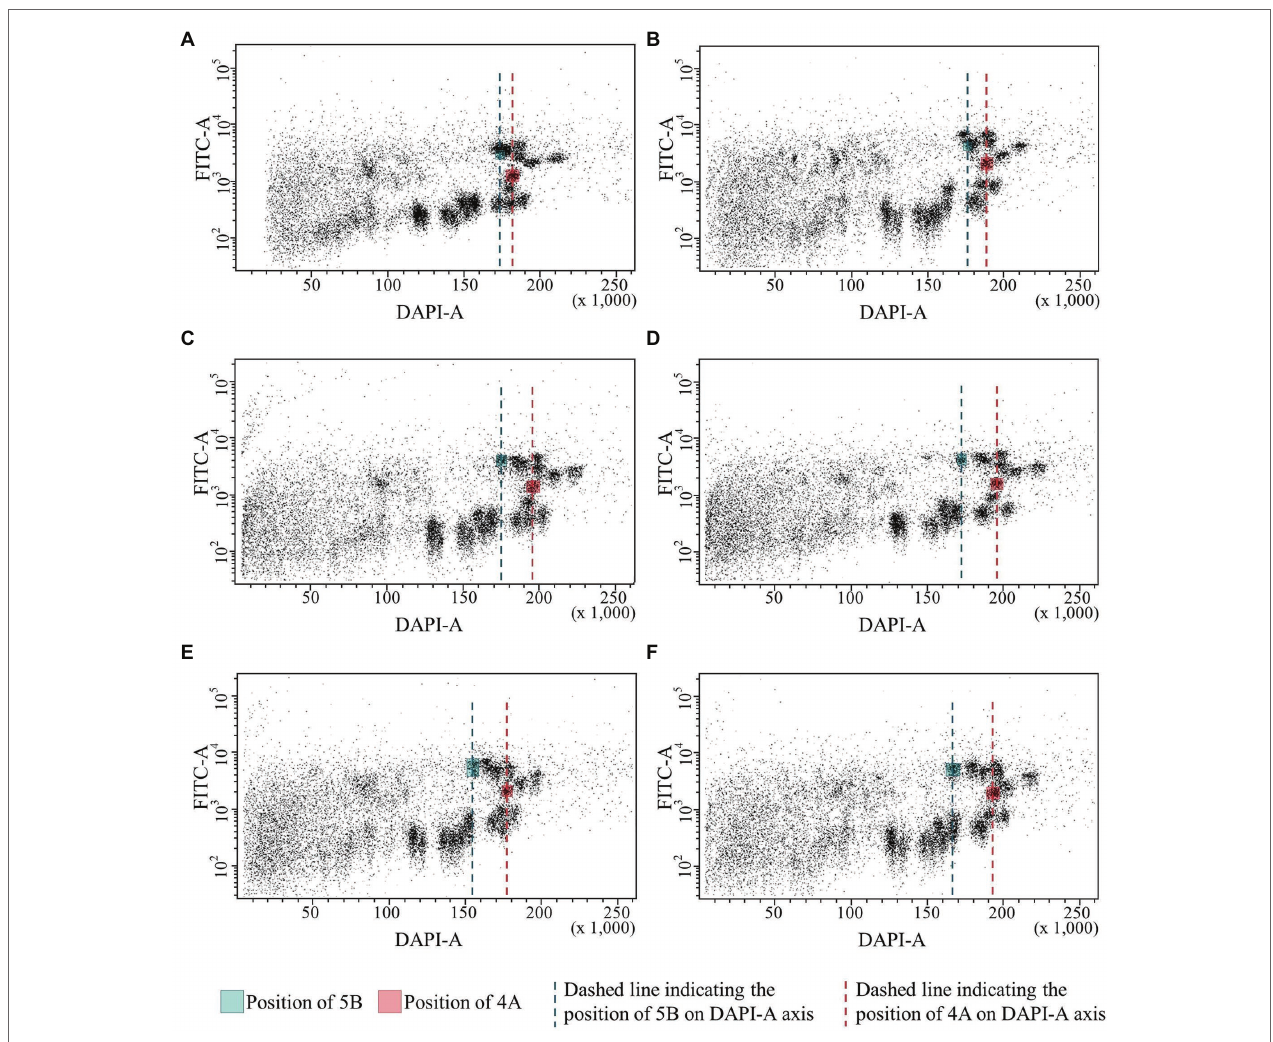
FIGURE 4 | Bivariate flow cytometric analysis (flow karyotyping) of chromosomes isolated from wild-type and ph1b mutant wheat lines allows discrimination between the populations of wild-type and deleted chromosome 5B (green line) and chromosome 4A, which served as a reference (red line). Note that the populations of wild-type chromosome 5B in Chinese Spring (A) and Mv9kr1 (B) lines are closer to the position of 4A population on the DAPI axis. Chromosome 5B populations in CS ph1b _K (C) and CS ph1b _N (D) lines have lower DAPI fluorescence intensity and hence are more separated from chromosome 4A population. The same difference between the positions of 5B and 4A chromosomes was detected in Mv9kr1 ph1b _K (E) and Mv9kr1 ph1b _N (F)